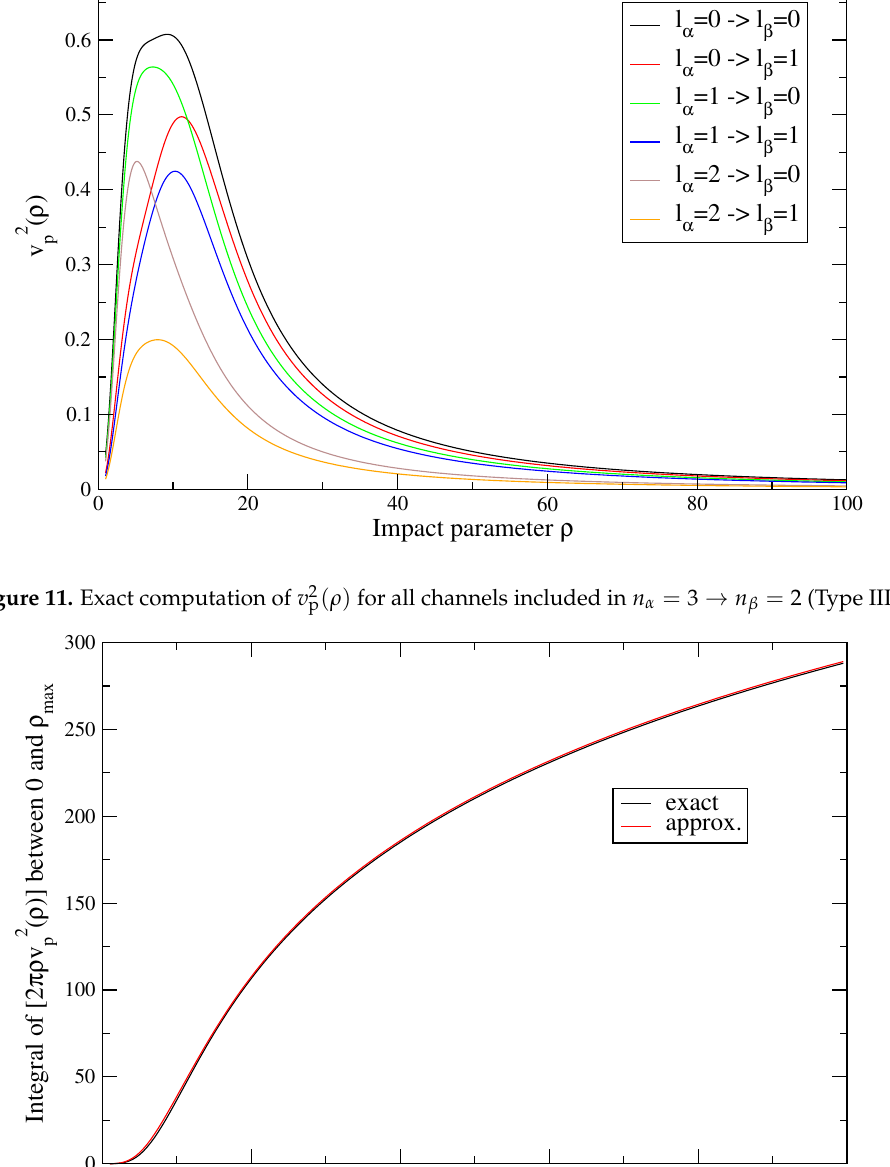
(cid:82) ρ max Figure 12. Comparison between exact expression of 2 πρ v 2 p ( ρ ) d ρ and the approximate expression 0 v p,app (see Equation (63)) in the framework of Penetration Theory for n α = 3, (cid:96) α = 2, m α = 1, n β = 2, (cid:96) = 1, m = 0, (cid:96) = m = 1, and (cid:96) = m = 0 as a function of ρ max α (cid:48) α (cid:48) β β β (cid:48) β (cid:48)